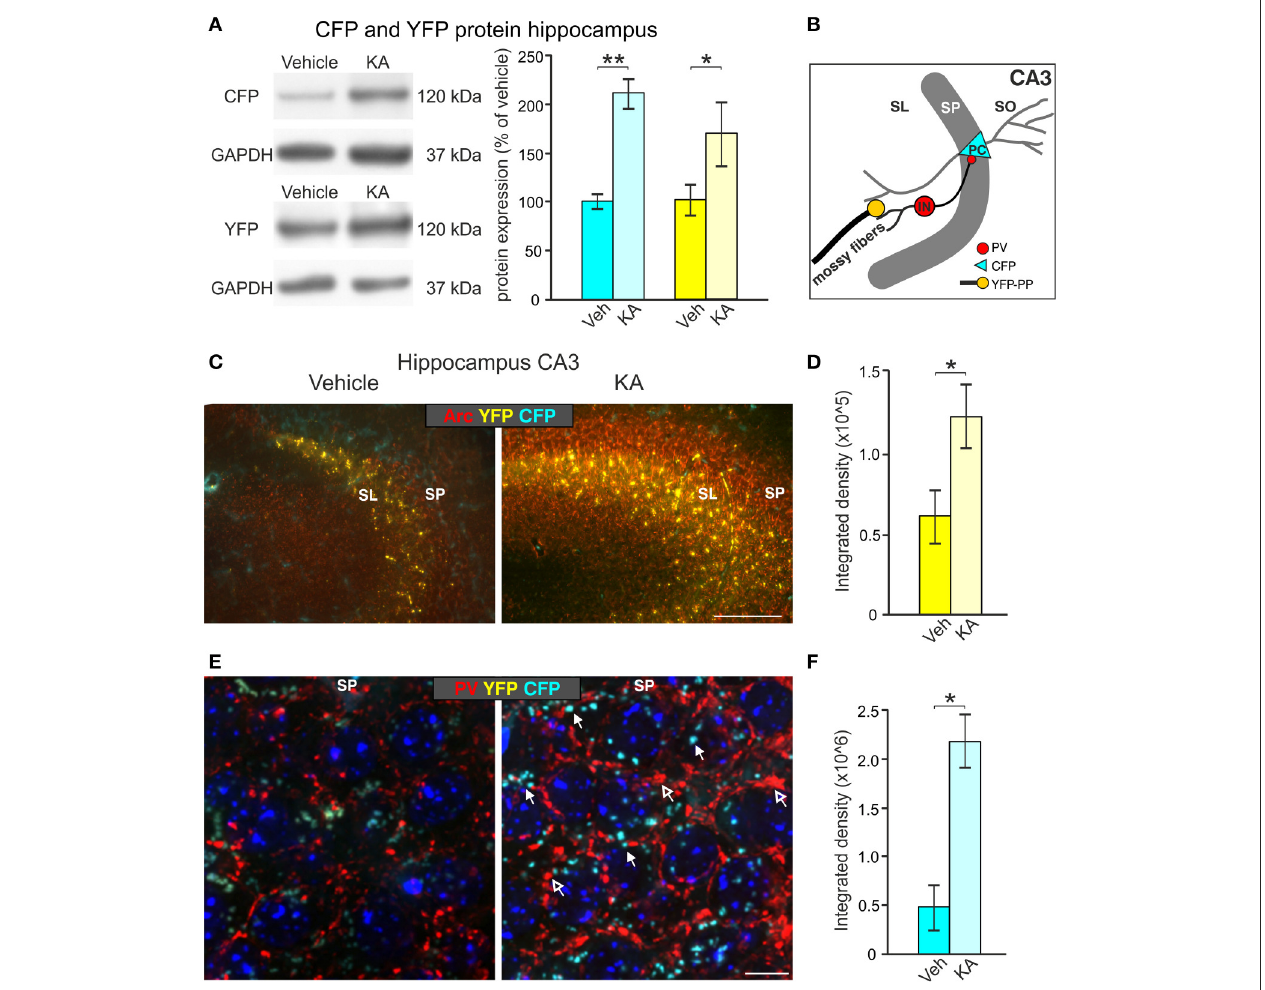
FIGURE 7 | Induction of CFP and YFP expression by kainic acid treatment (KA). (A) Western blot analysis of hippocampal tissue lysates from animals injected with vehicle or KA. Left panel: representative Western blot against CFP (top) and YFP (bottom). Right panel: densitometric quantification shows significant up-regulation of CFP and YFP expression after KA treatment. Data represented as mean ± SEM normalized to vehicle treated controls, n = 3–4 animals/group (CFP: 1-sided Student’s t -test: t = 6.25 DF = 4 p = 0.002; n = 3 animals/group; YFP: 1-sided Student’s t -test: t = 1.99 DF = 6 p = 0.04; n = 4 animals/group). For original blot see Supplementary Figure 6C . (B) Schematic overview of the hippocampal CA3 region depicting the assumed locations of altered CFP, YFP and Parvalbumin (PV) expression. (C) CFP and YFP fluorescence in brain slices of vehicle- and KA-treated animals co-labeled with the cytoskeletal activity-regulated gene Arc. Clear upregulation of Arc (red) mainly in the SP and YFP mainly in the SL can be seen in the hippocampal CA3 region of KA-treated animals in comparison to vehicle-treated mice. Scale bars: 100 µ m. (D) Quantification of the integrated density of YFP which is increased after KA injection (YFP: 1-sided Student’s t -test: t = 4.14 DF = 3 p = 0.0128; n = 3 animals/group). (E) An increase in perisomatic CFP (closed arrows) and PV (red, open arrows) signals can be seen in the SP of the hippocampal CA3 region in KA-treated animals in contrast to vehicle-treated mice. Scale bars = 10 µ m. (F) Quantification of the integrated density of CFP which is increased after KA injection (CFP: 1-sided Student’s t -test: t = 2.32 DF = 4 p = 0.0405; n = 2–3 animals/group). SL, stratum lucidium; SP, stratum pyramidale; SO, stratum oriens; PC, pyramidal cell; PP, perforant path; IN,